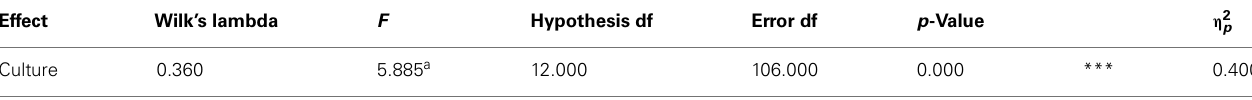
TableA3 | Between-subjects MANOVA testing the effect of culture on mean ipsatized ratings.